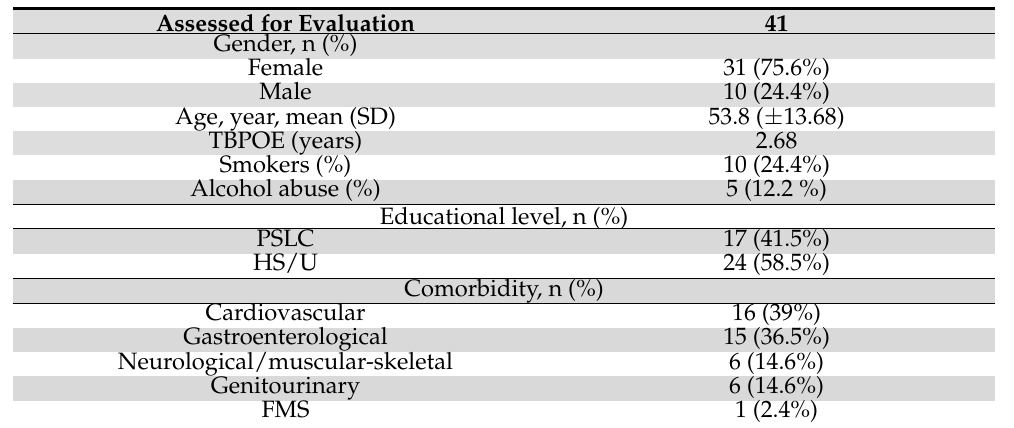
Table 1. Demographic characterization of PIFP population (41 patients).